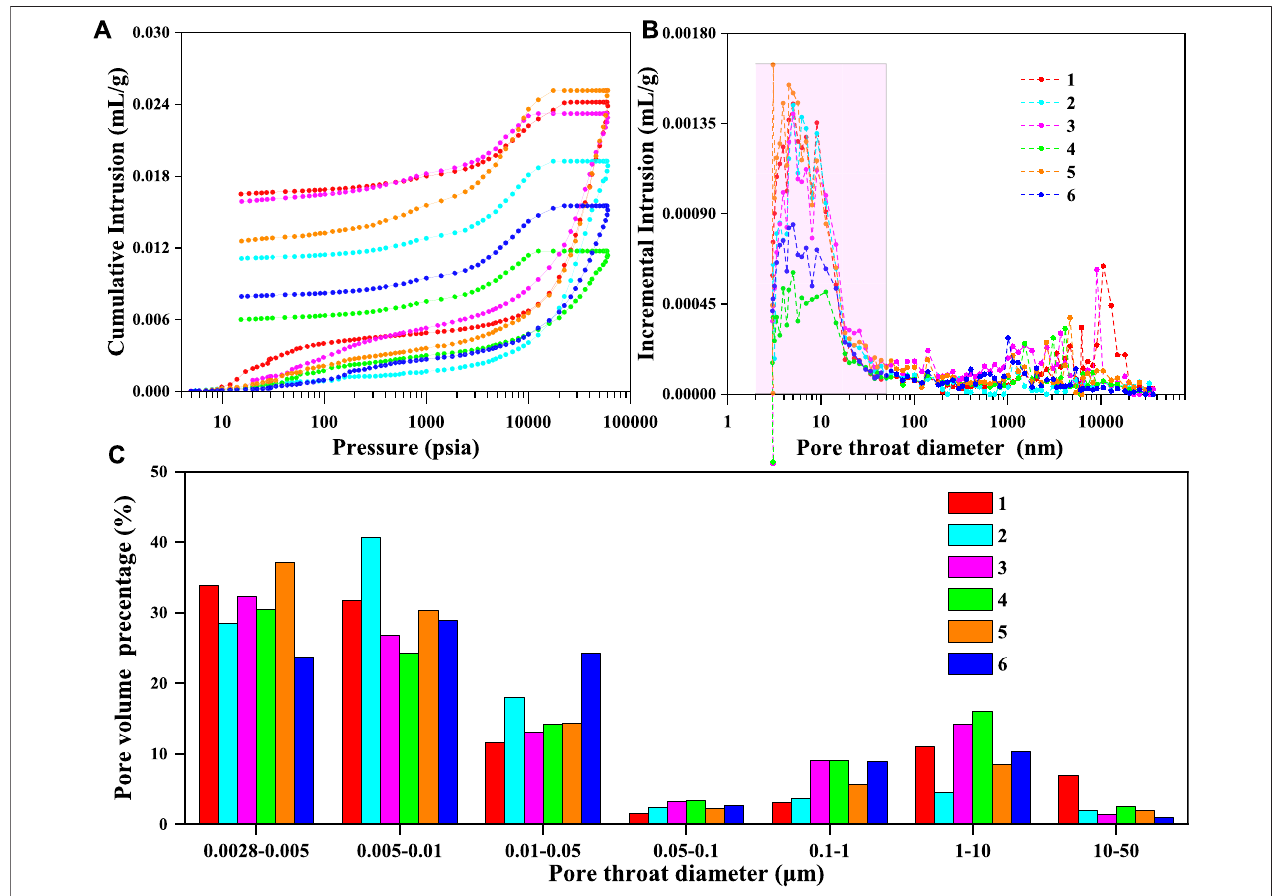
FIGURE 4 | (A) Cumulative mercury intrusion and extrusion vs. applied pressure from MIP tests; (B) Incremental intrusion distribution across nanometer- micrometer spectrum; and (C) pore volume percentage as a function of pore-throat size distribution.